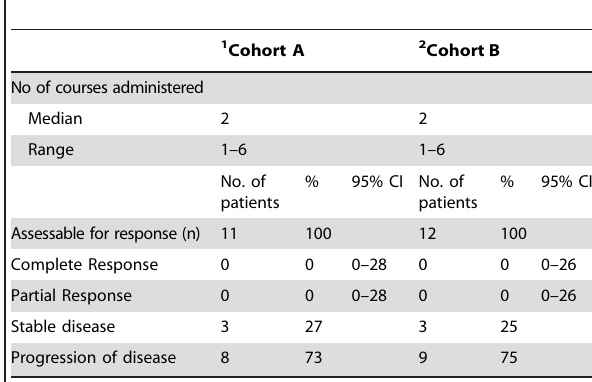
Table 2. Summary of treatment and